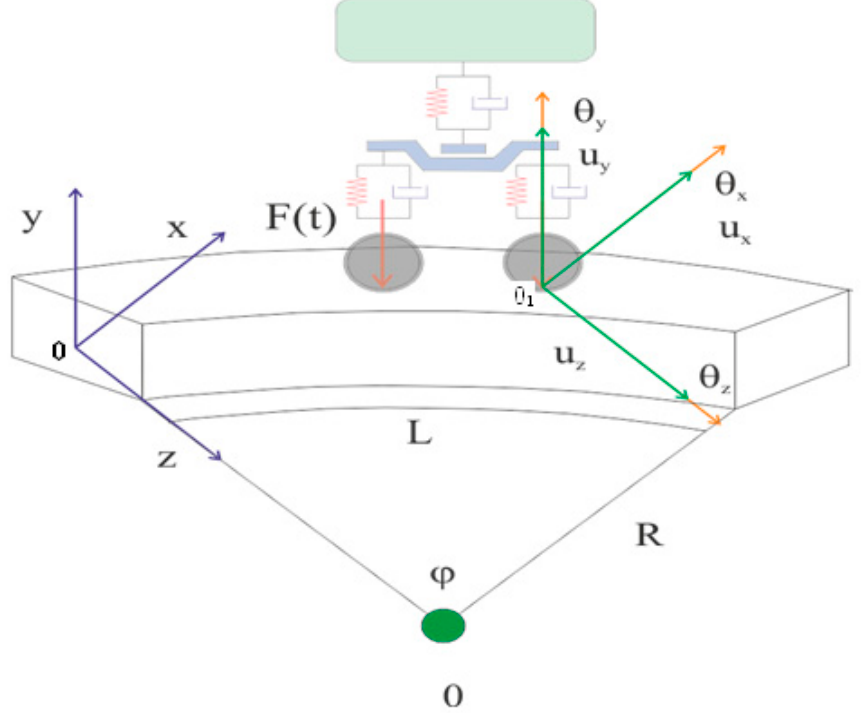
Figure 7. Model of a curved beam with a variable cross-section used in mathematical modeling, 0 1 - contact point between the wheel and the rail.